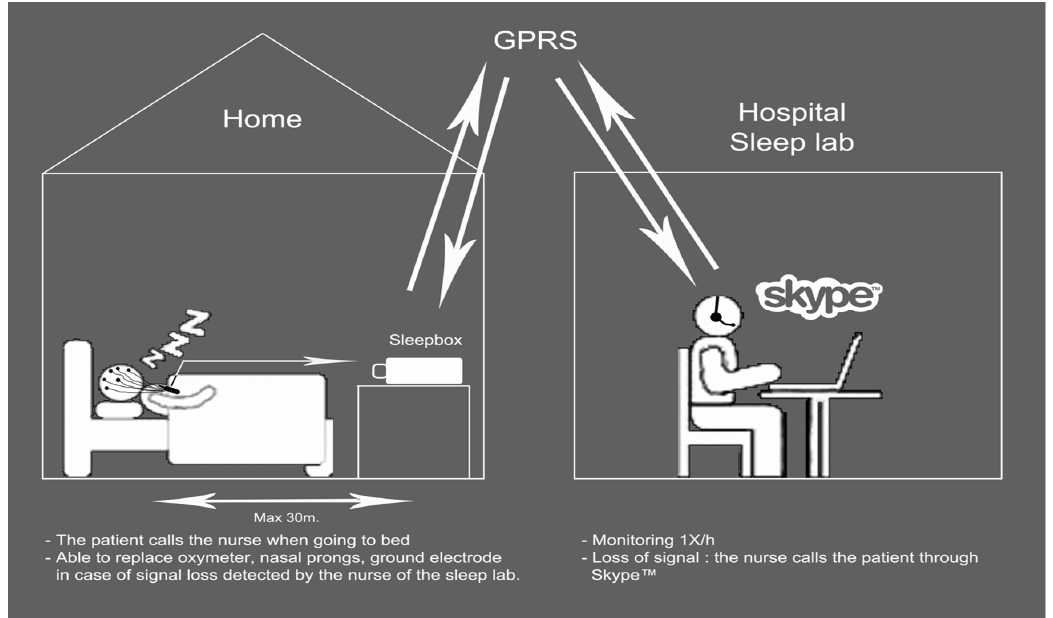
recording. From Bruyneel et al. [11] Int. J. Med. Inform. 2013 , 82 , 696–701, Copyright © 2013 with permission from